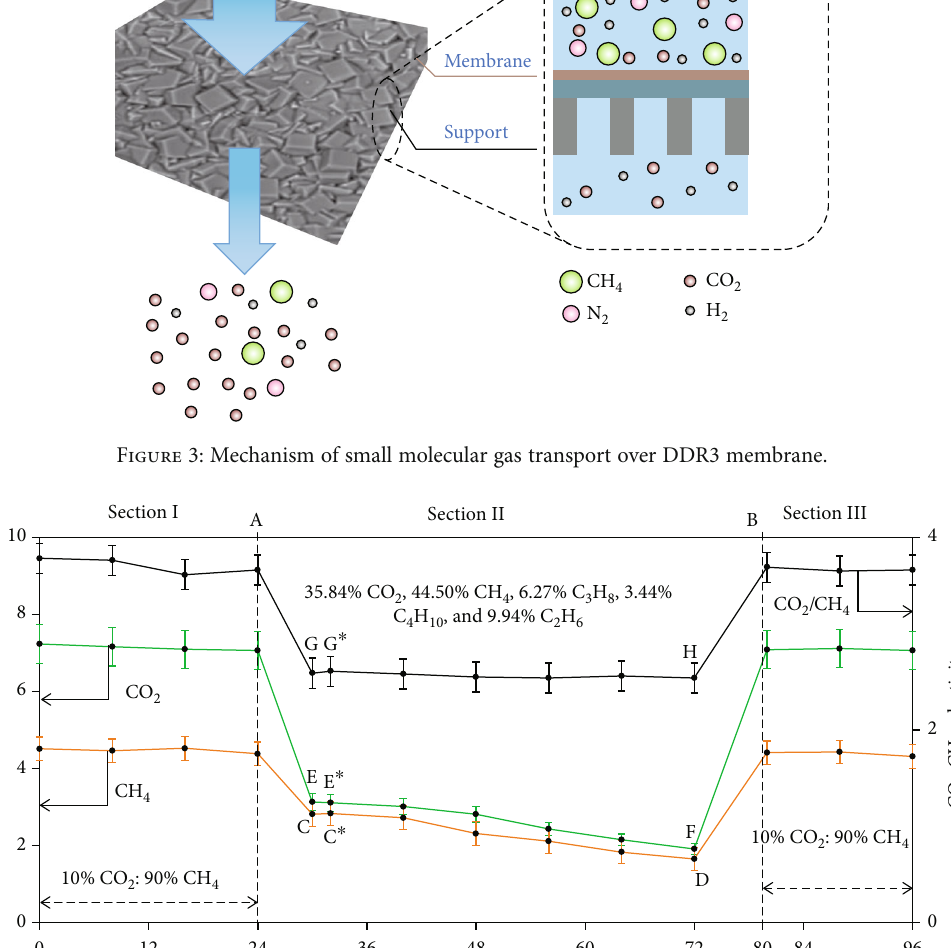
composition of 35.84% (CH composition of 2 4